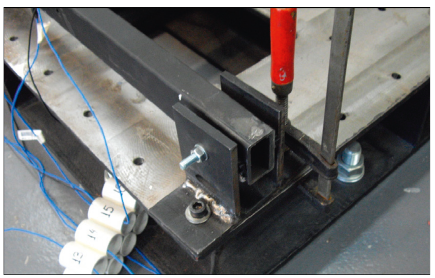
Figure 14: Details of the Table 10: Experimental, numerical, and predicted natural frequencies for pinned-free configuration.